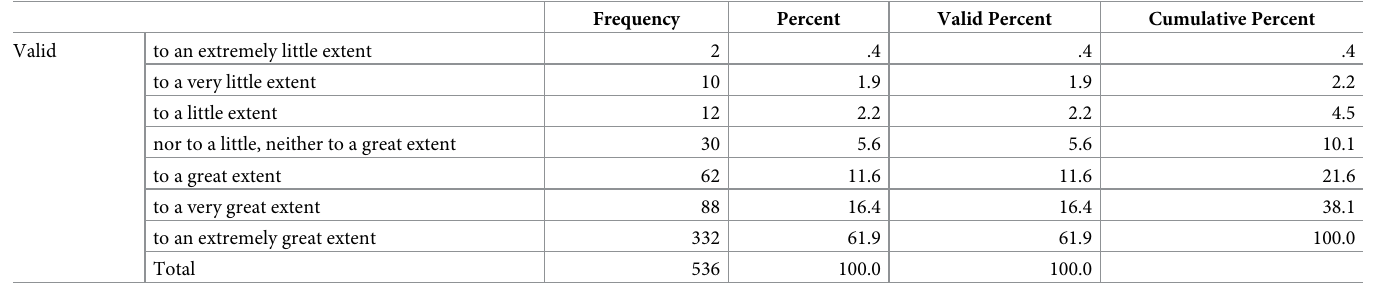
Table 8. Perception about the extent to which social media contributed to the spread of medical fake